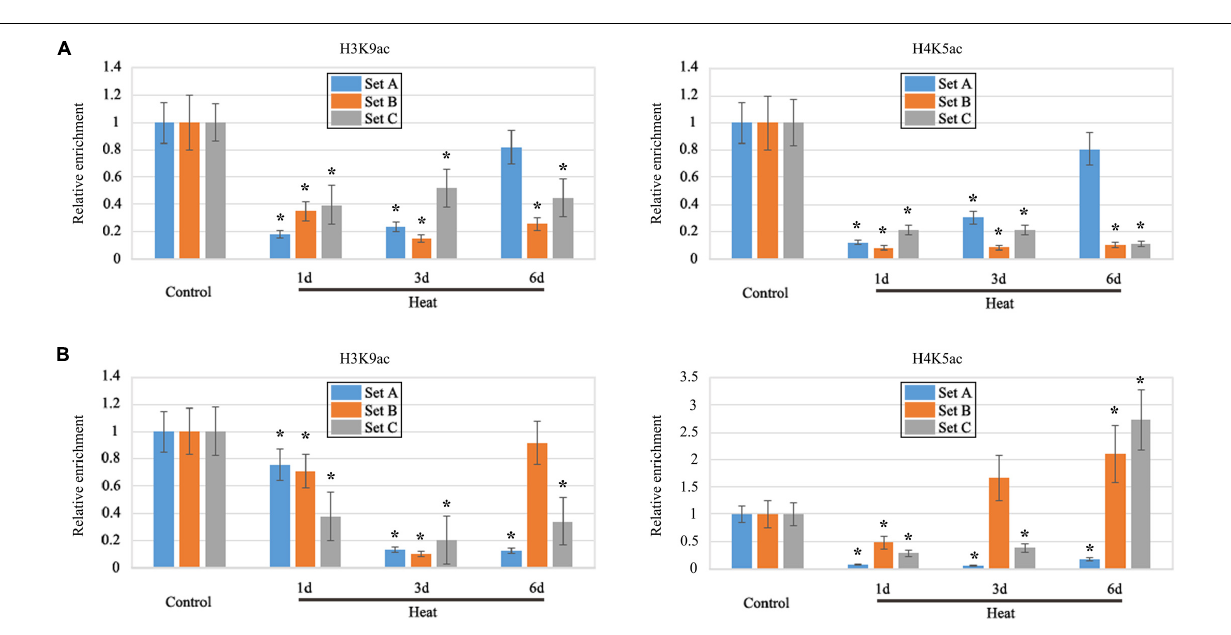
FIGURE 6 | ChIP analysis. It revealed that the modification of H3K9ac and H4K5ac in the promoter region of ZmHO-1 and ZmGSL-1 genes was significantly altered under the heat stress. (A) The level of H3K9ac and H4K5ac in the upstream region of ZmHO-1 gene was significantly decreased under heat treatment. (B) The level of H3K9ac in the upstream region of ZmGSL-1 gene was significantly decreased and H4K5ac was found to be slightly present on the set B after 3 days of treatment, whereas it increased significantly on the set C after 6 days of treatment. The acetylation level of the control group was set to 1.0 at each time point. The relative abundance of histone modification was repeated three times. Asterisk ( ∗ ) indicated that the relative increase of H3K9ac or H4K5ac under heat treatment group is significantly different from that of the control group ( t -test, p <